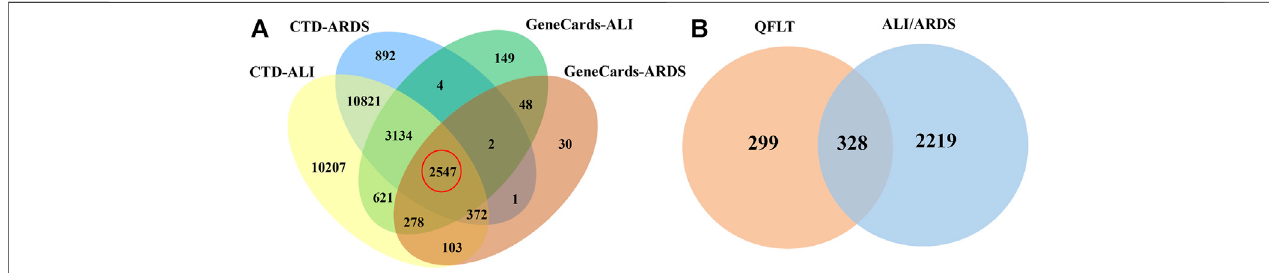
FIGURE 3 | Venn diagram. (A) ALI/ARDS putative targets collected from two databases. (B) potential overlapping targets between QFLT and ALI/ARDS.